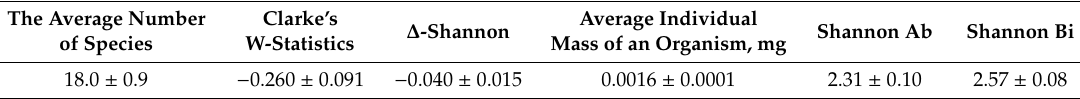
Table 4. Structural variables of zooplankton of Lake Borovoe, 2019 (mean with standard error). The Average Number Clarke’s of Species W-Statistics